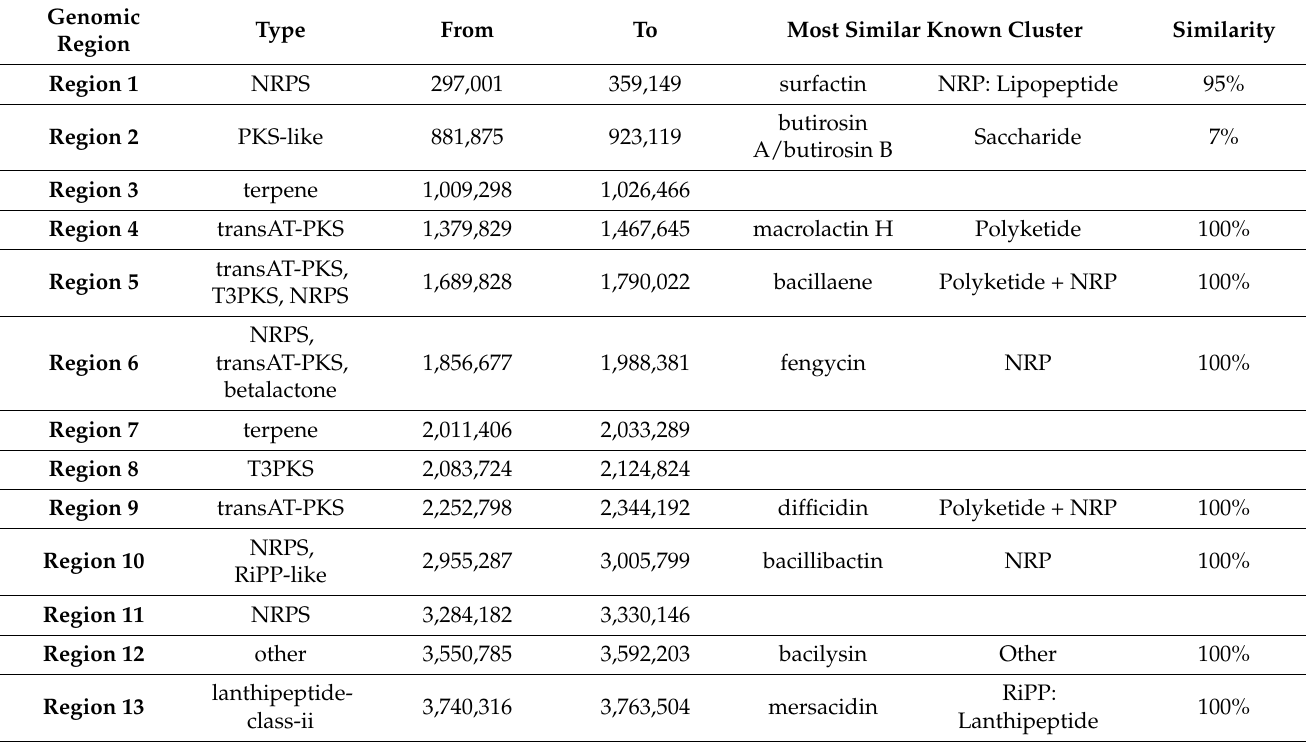
Table 6. Secondary metabolite biosynthetic gene clusters into genomic regions of B. velezensis